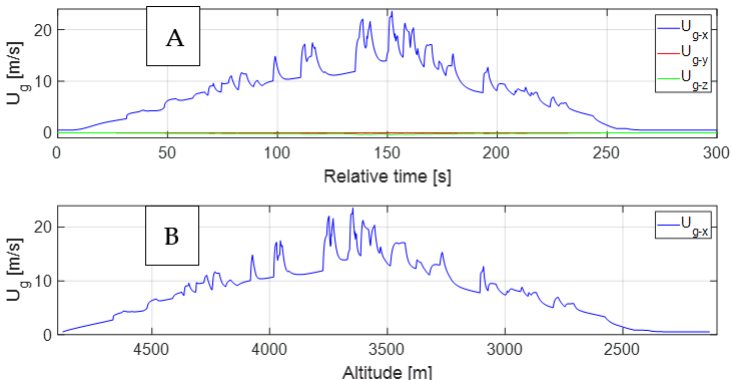
Figure 13. Registered ideal gust measurements from simulation weather section; ( A ) wind speed as a function of time, ( B ) wind speed as a function of altitude.